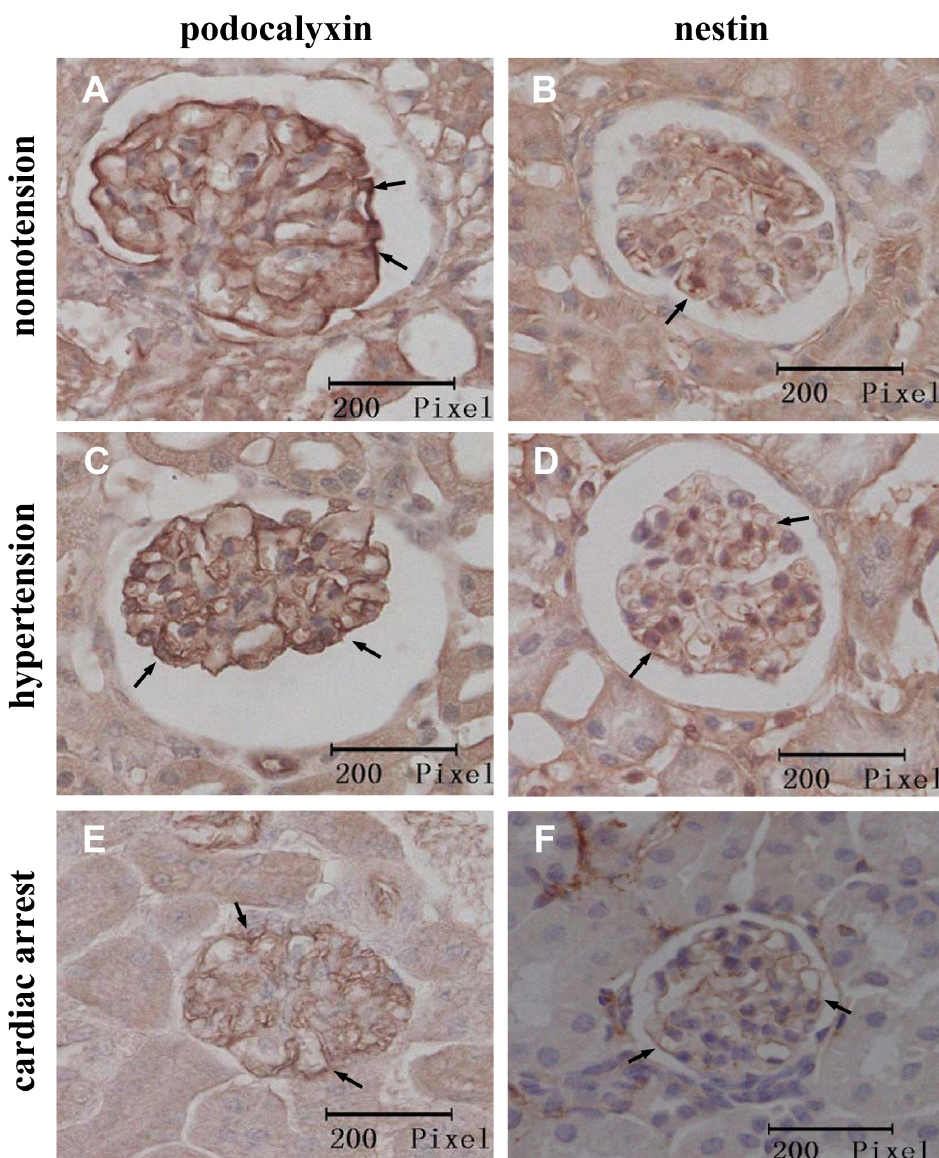
Figure 3. Immunohistochemical localization of the podocyte proteins in kidney tissues prepared with the IVCT and immersion-fixation methods under various hemodynamic conditions. The micrographs in the left column show the localization of podocalyxin (PCX) (arrows), and those in right column show nestin localization (arrows). The immunohistochemical localization of the two proteins prepared with IVCT are shown under the normotensive ( A , B ), acute hypertensive ( C , D ), and cardiac arrest ( E , F ) conditions. The tissues in G and H under normotensive condition were treated by the immersion-fixation